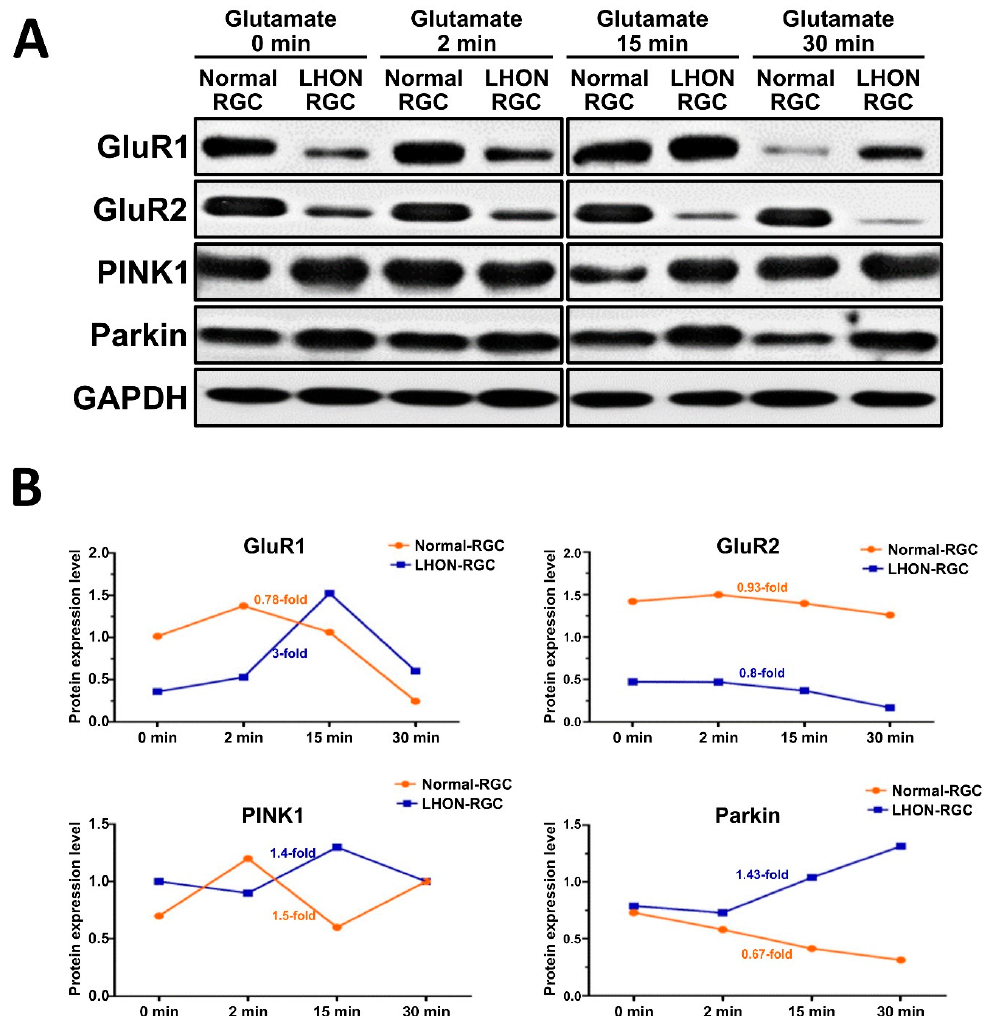
Figure 6. E ff ects of glutamate stimulation on the expression of AMPA receptors in LHON-RGCs. ( A ) Immunoblot analysis of the e ff ect of treatment of Normal-RGCs and LHON-RGCs with 10 µ M glutamate for the indicated time periods on expression levels of AMPA receptors and PINK1 and Parkin scaffold proteins. GAPDH used as a loading control ( B ) The protein expression level of GluR1 / R2, PINK1 and Parkin in Normal- and LHON-RGCs were quantified by Image J.